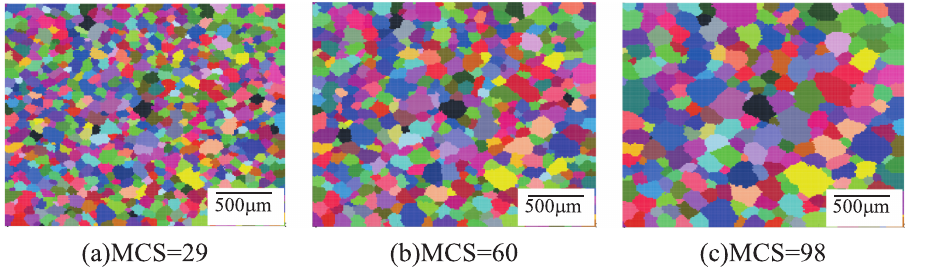
Figure 9: Grain growth of α / β phases in HAZ in 1100 rpm and 0.5mm/s.